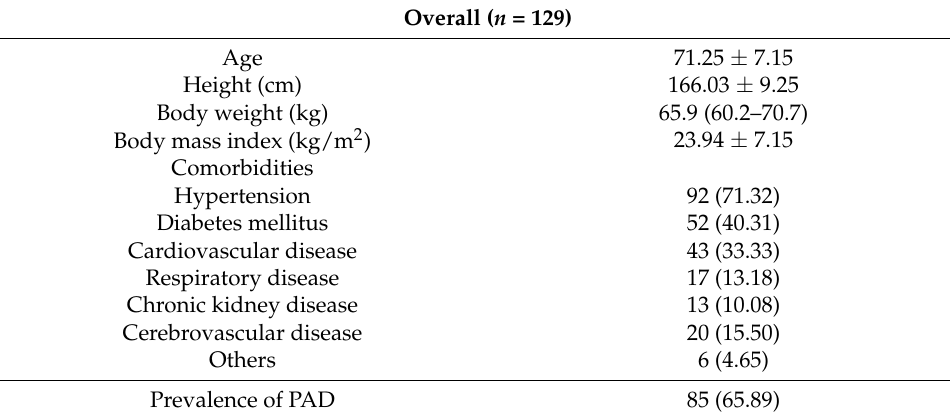
Figure 1. Flow diagram of the participants in this study. Table 2. Characteristics of the patients.